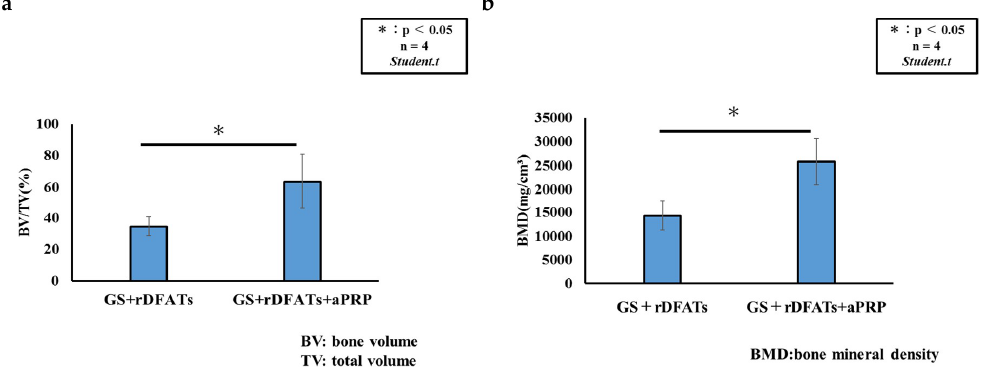
Figure 12. Morphometric analysis of bone defects. Quantitative analysis of micro‐computed tomography data for each defect. GS: gelatin sponge, rDFATs: rat dedifferentiated fat cells, aPRP: activated platelet-rich plasma ( a ) BV: bone volume; TV: total volume. ( b ) BMD: bone mineral density.